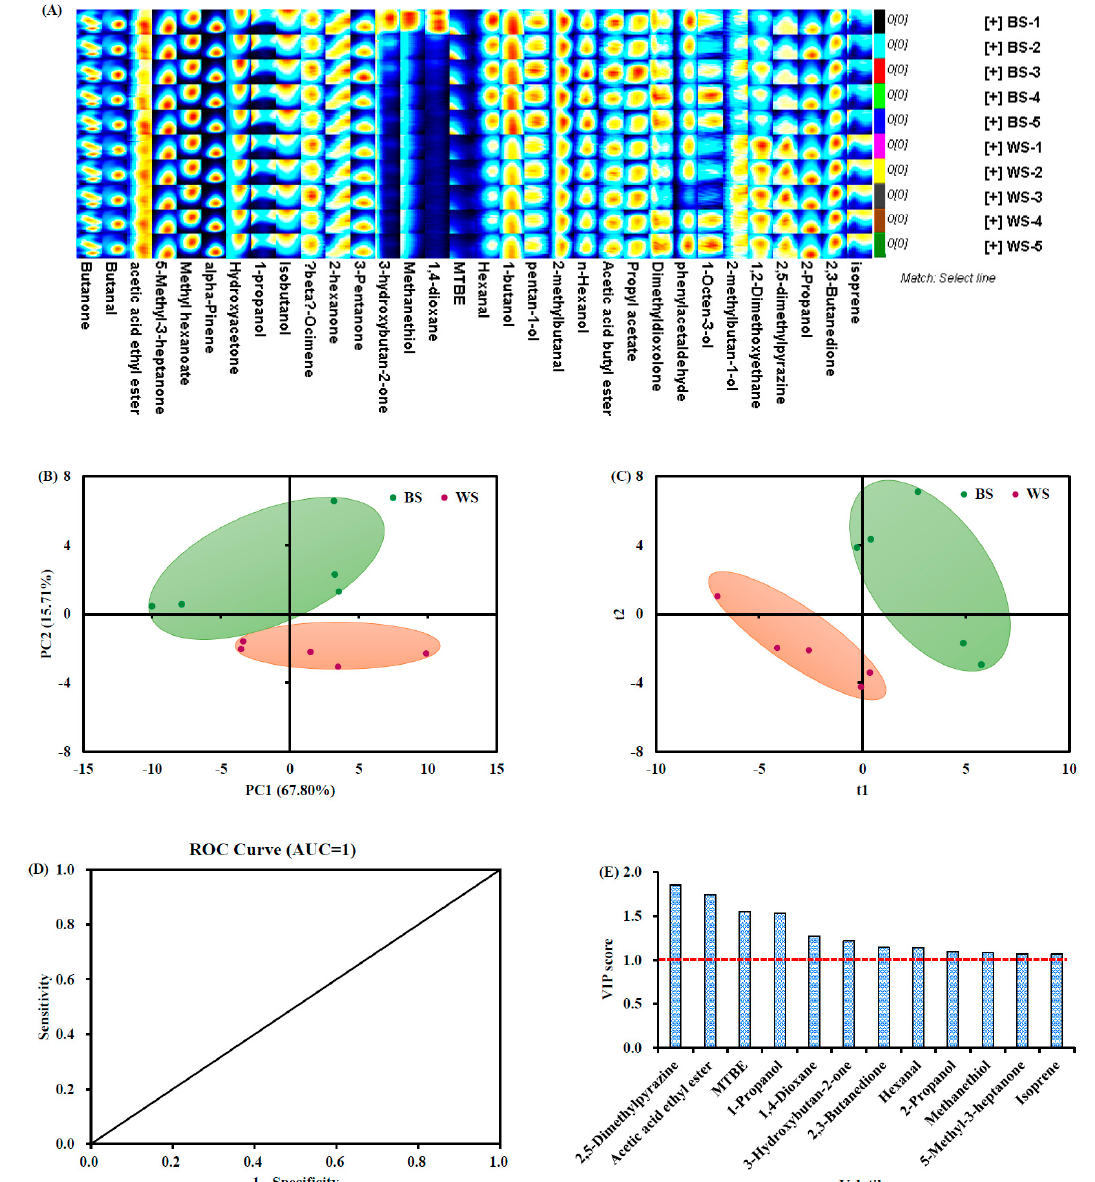
Figure 2. ( A ) Volatile fingerprints of the black and white sesame seeds. The picture was output automatically by the Laboratory Analytical Viewer (LAV) with reporter and three gallery plug-ins. The reporter plug-in enables comparison of the spectral differences, whereas the gallery plot plug-in visually compares the volatile fingerprints between different samples. Each row represents an individual sesame seed sample, whereas each column represents an individual volatile organic compound detected in different samples. The redder color means higher concentration levels of the volatiles. ( B ) Score plot of PCA on the volatile organic compounds. ( C ) Score plot of PLS-DA on the volatile organic compounds (R 2 X = 0.96, R 2 Y = 0.99 and Q 2 = 0.94). ( D ) ROC curve of the volatile constitutes. ( E ) Bar chart of the VIP scores of the potential aroma markers for separating the two types of sesame seeds. BS, black sesame seeds; WS, white sesame seeds; ROC, receiver operating characteristic; VIP, variable importance in projection.